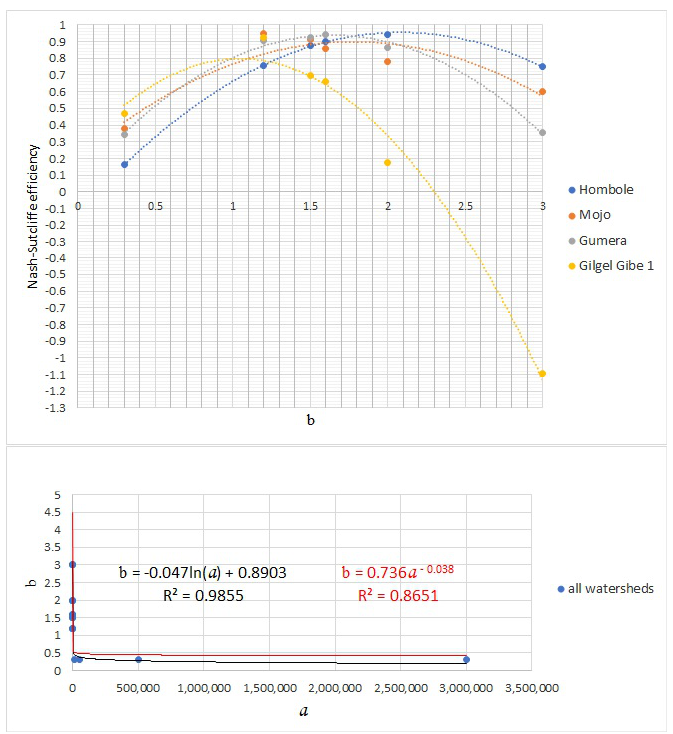
Figure 10. The relationship between exponent b versus the Nash–Sutcliffe efficiency and coefficient a versus exponent b when the topographic factor is calculated by using the equation that was proposed in